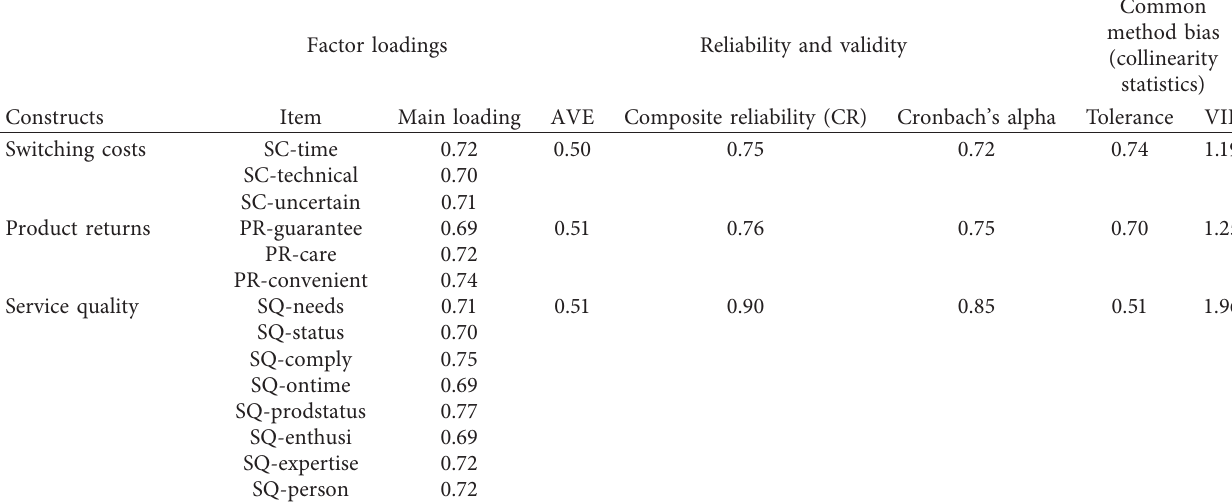
Table 8: Measurement model result